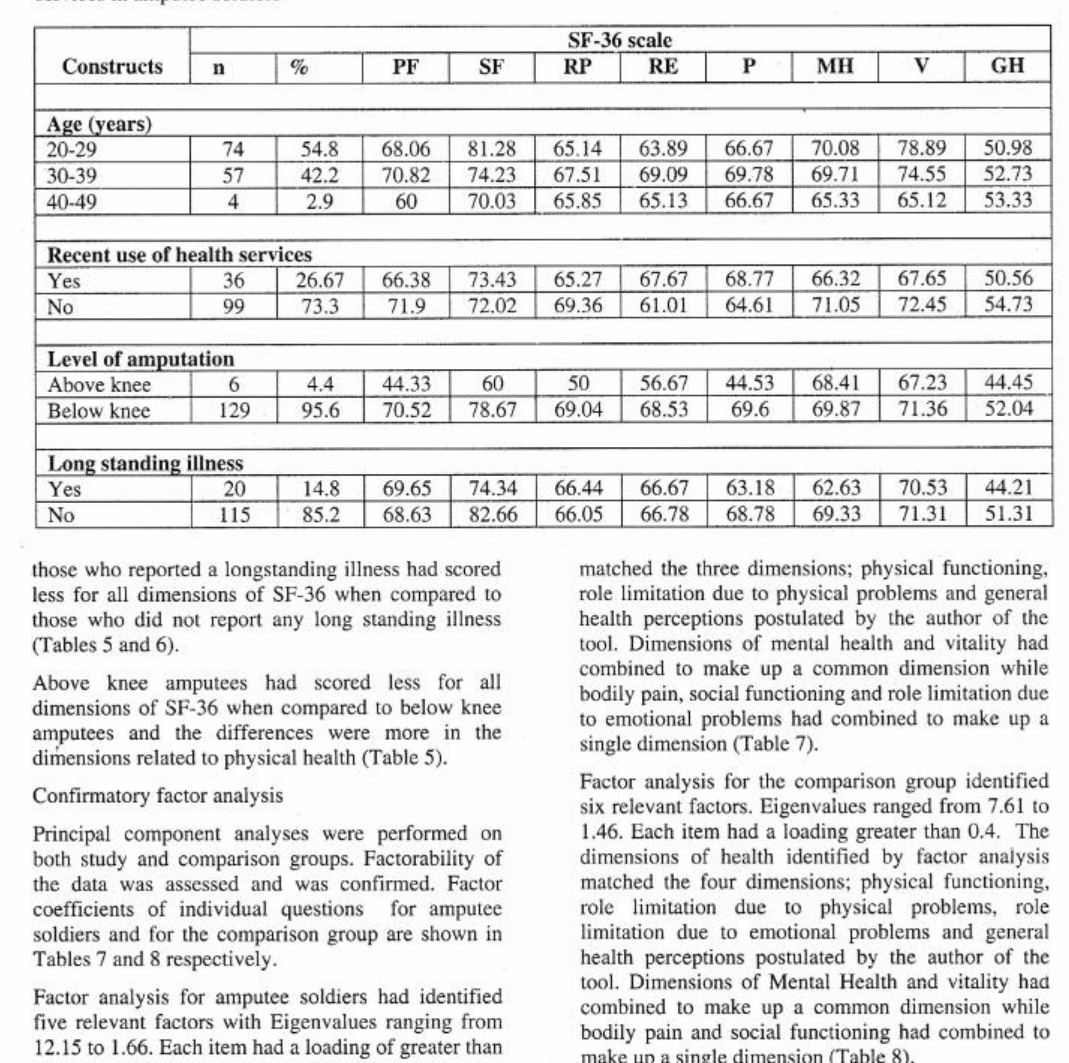
Table 5- Meanscores on dimensions ofSF-36 in relation to some socio-demographic variables and use of health